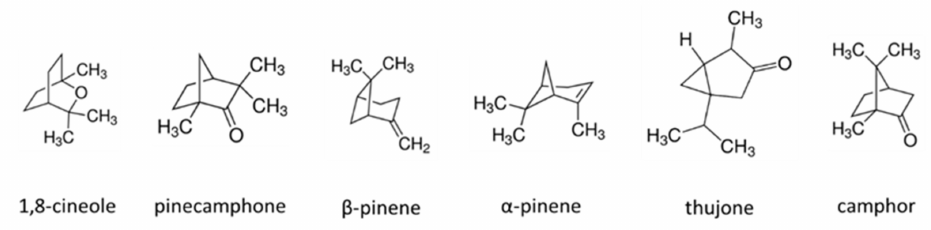
Figure 6. The structural formula of main active compounds of